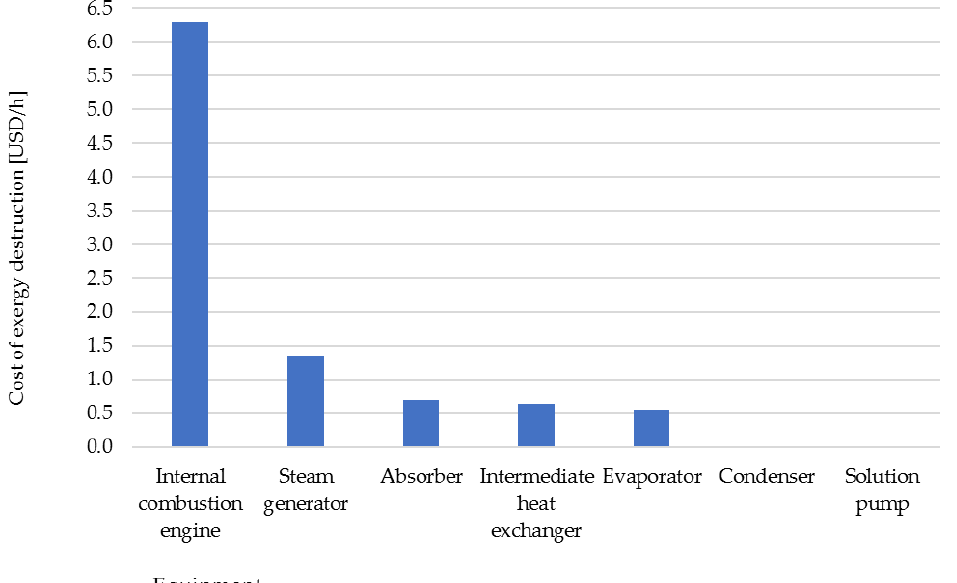
Figure 2. Costs associated with the destruction of exergy, in USD/h.